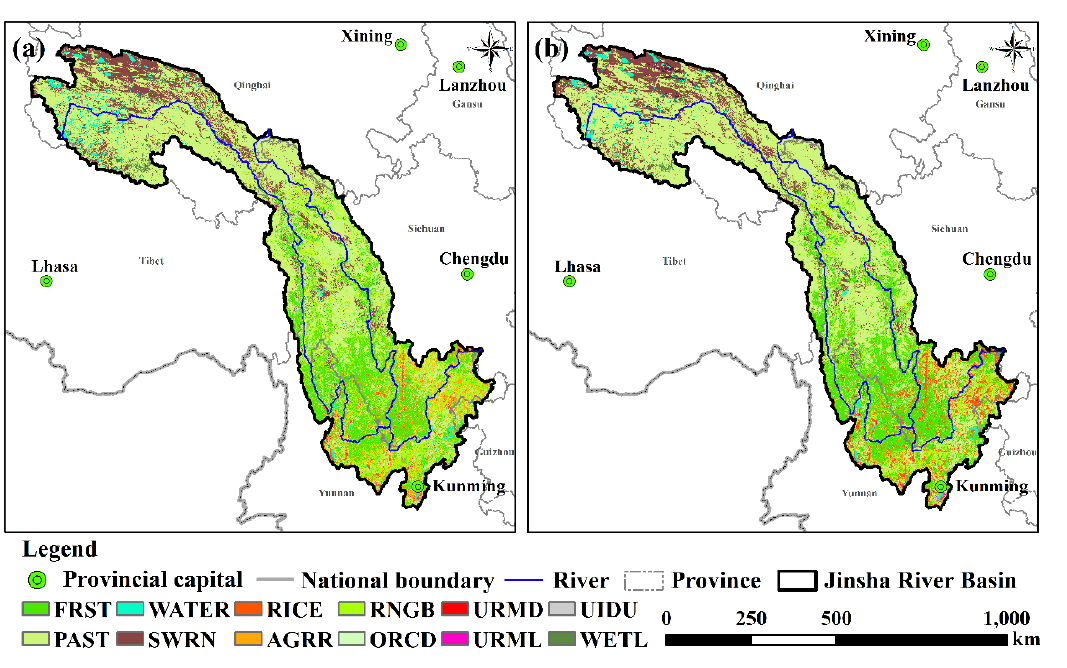
Figure 4. The Landuse of JRB in 1980 ( a ) and 2000 ( b ).